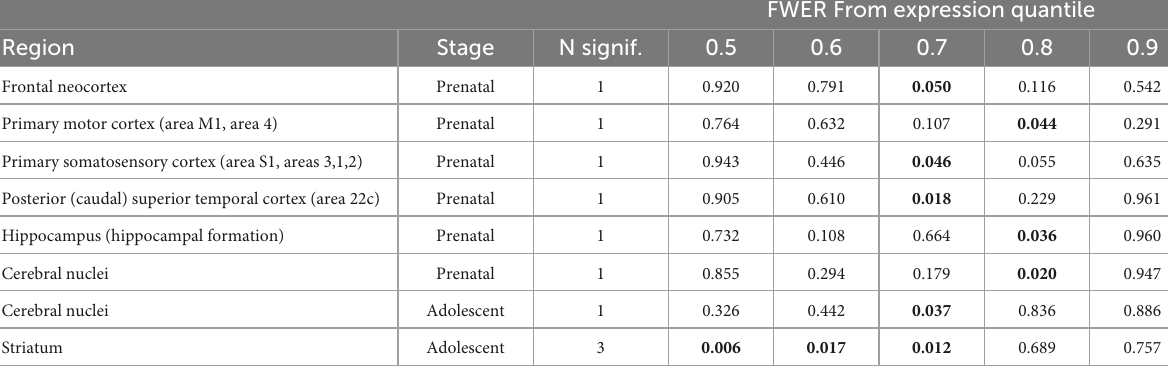
TABLE 2 ABAEnrichment in region-stage combination for SV containing genes identified by PacBio